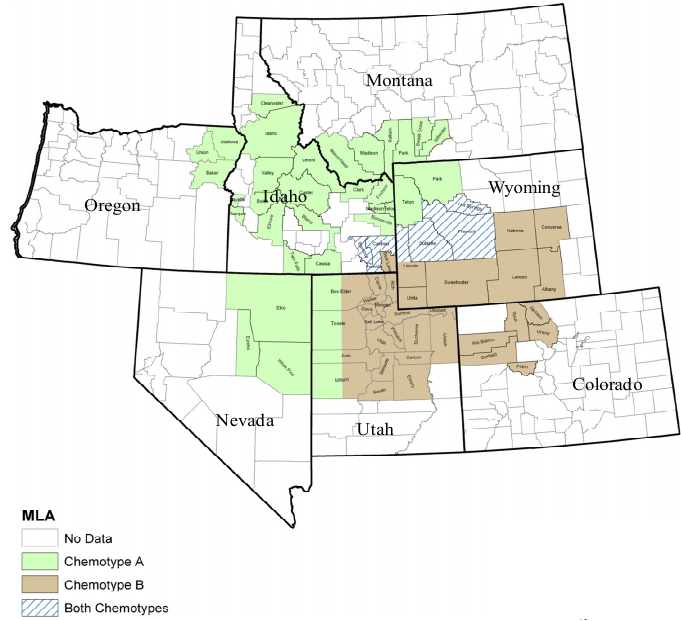
Figure 3. Distribution map of two chemotypes of D. occidentale. Chemotype A plants contain the MSAL-type alkaloids whereas chemotype B plants do not contain the MSAL-type alkaloids (modified from [19])